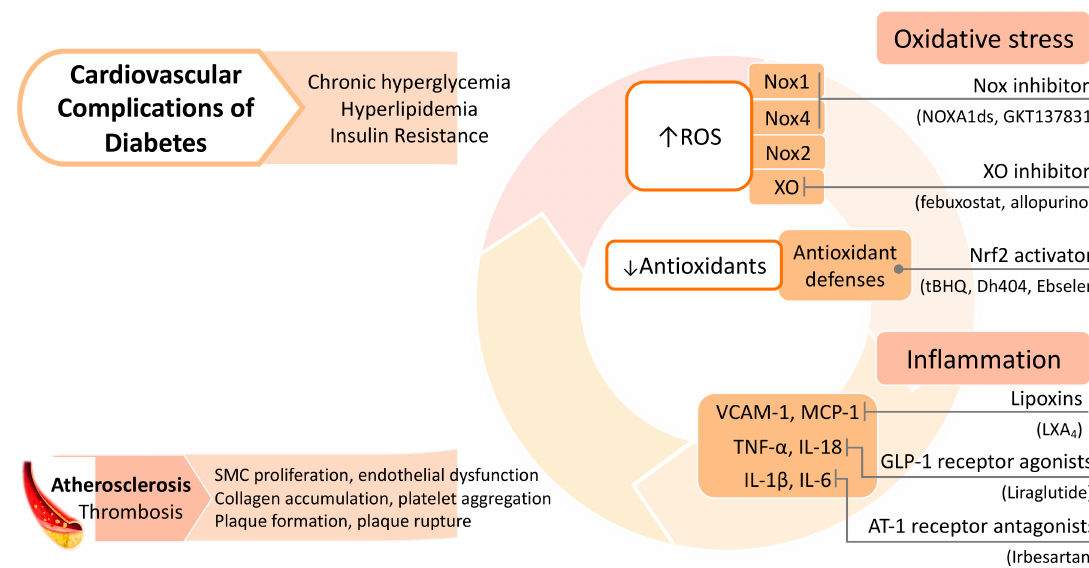
Figure 2. Pathophysiology and therapeutic strategies of diabetes associated cardiovascular disease. AT-1, angiotensin II type 1; GLP-1, glucagon-like peptide 1; IL, interleukin; MCP-1, monocyte chemotactic protein-1; Nox, NADPH oxidase; Nrf2, nuclear factor erythroid 2–related factor 2; ROS, reactive oxygen species; TNF- α , tumor necrosis factor alpha; VCAM-1, vascular cell adhesion protein 1; XO, xanthine